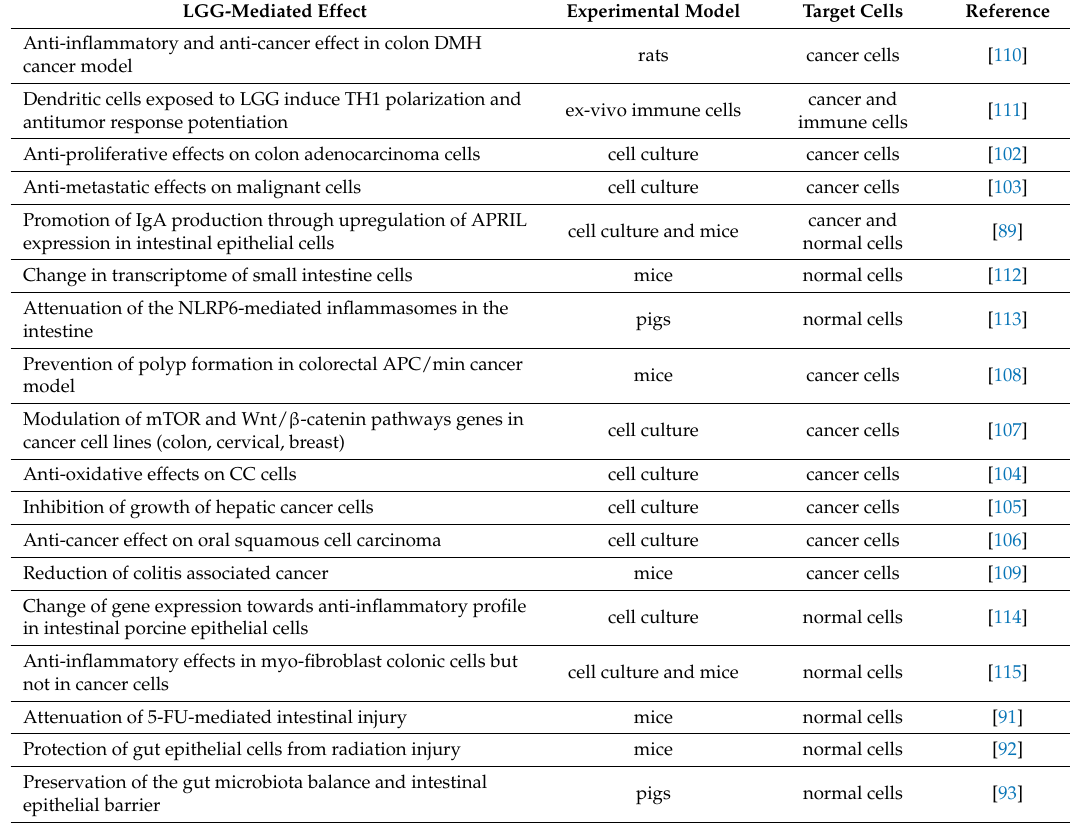
Table 2. The last three-years in vitro and in vivo studies describing the role of LGG in